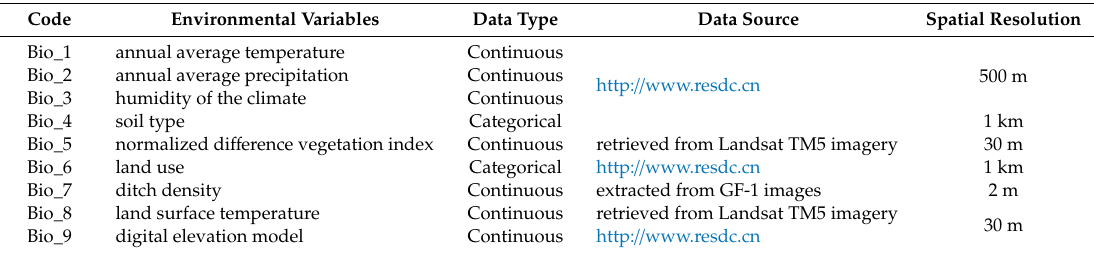
Table 1. Environmental variables used in the